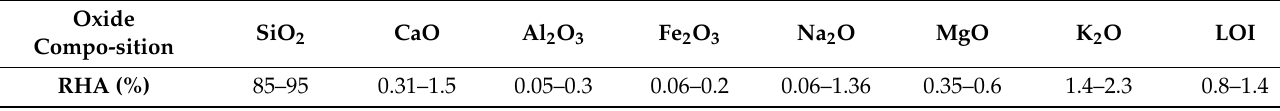
Table 5. Oxide composition of RHA [62–65,77].